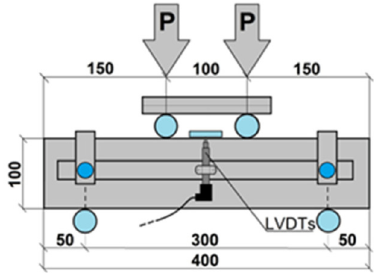
Table 1. Composition of SFRC with fibers of different types Tables ingredients